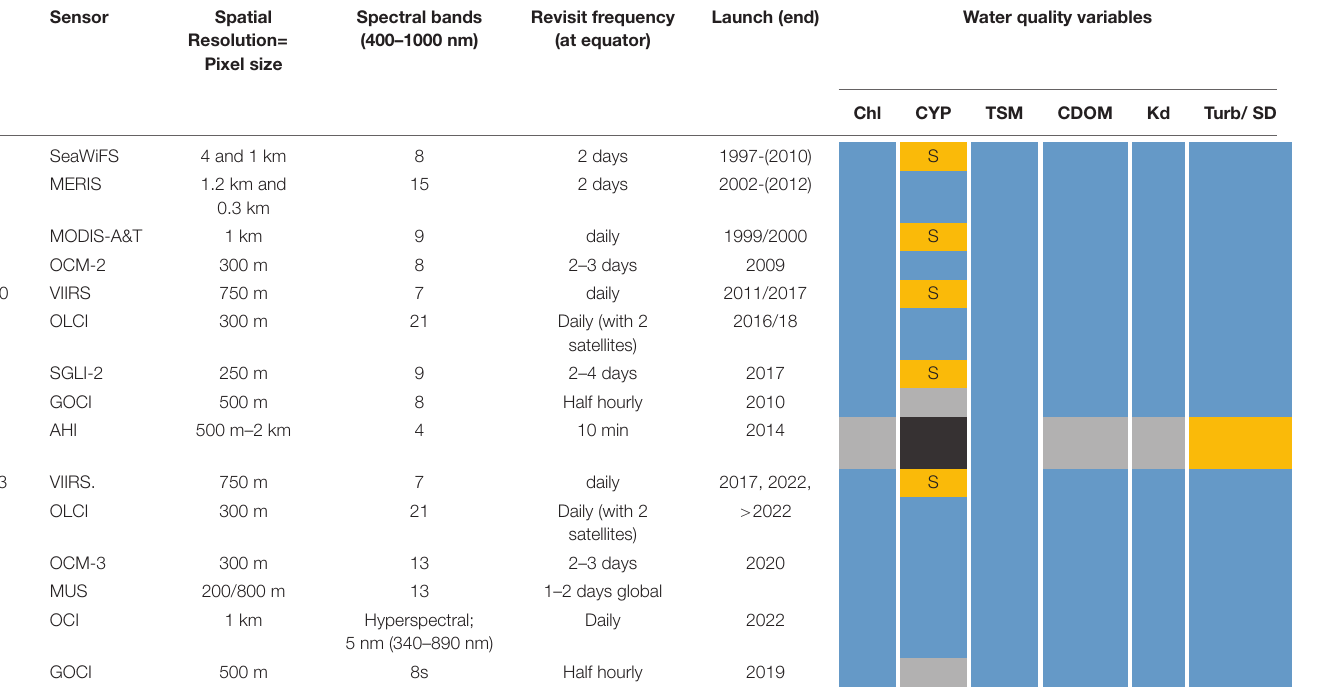
TABLE 2 | Recent, existing, and near-future satellite sensor systems of relevance for ocean colour (revised and updated after International Ocean Colour Coordinating Group [IOCCG], 2018).